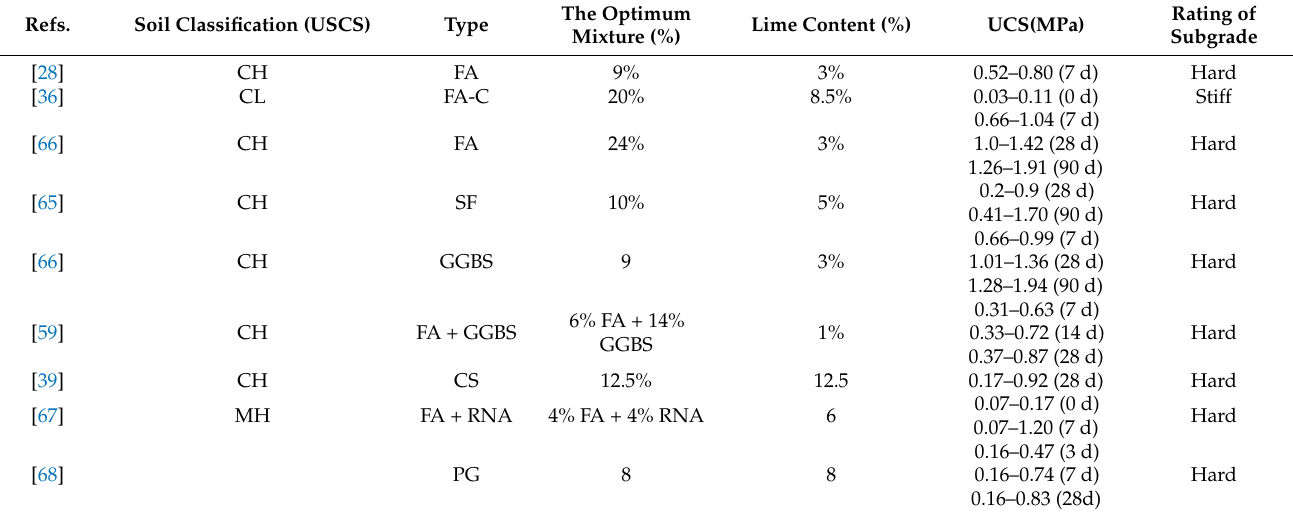
Table 2. Summary of the UCS of expansive soil stabilized by industrial solid waste and lime.